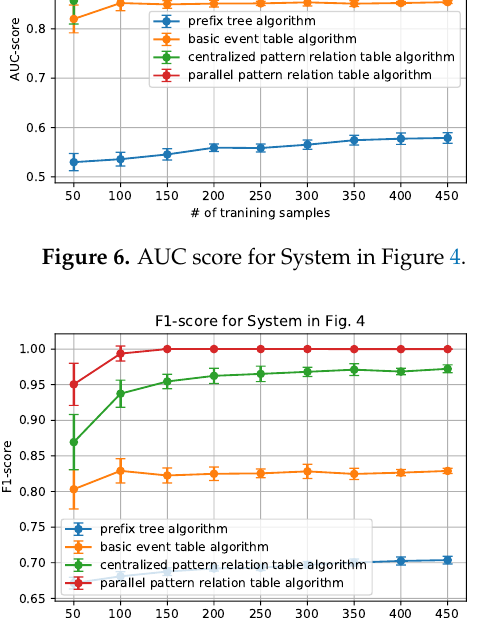
prefix tree algorithm basic event table algorithm centralized pattern relation table algorithm parallel pattern relation table algorithm